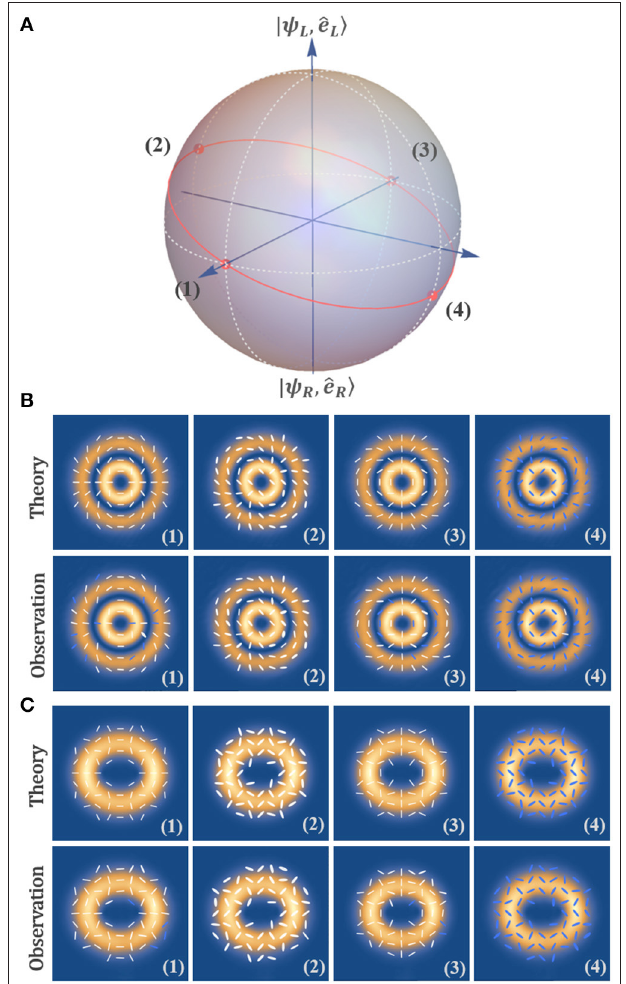
FIGURE 4 | Comparison of the generated and desired SOC states on high-order Poincaré sphere (A) and associated vector profiles (B, C) , where the vector profiles were obtained by the spatial Stokes tomography with a 10s on-chip accumulation and Fourier noise reduction.